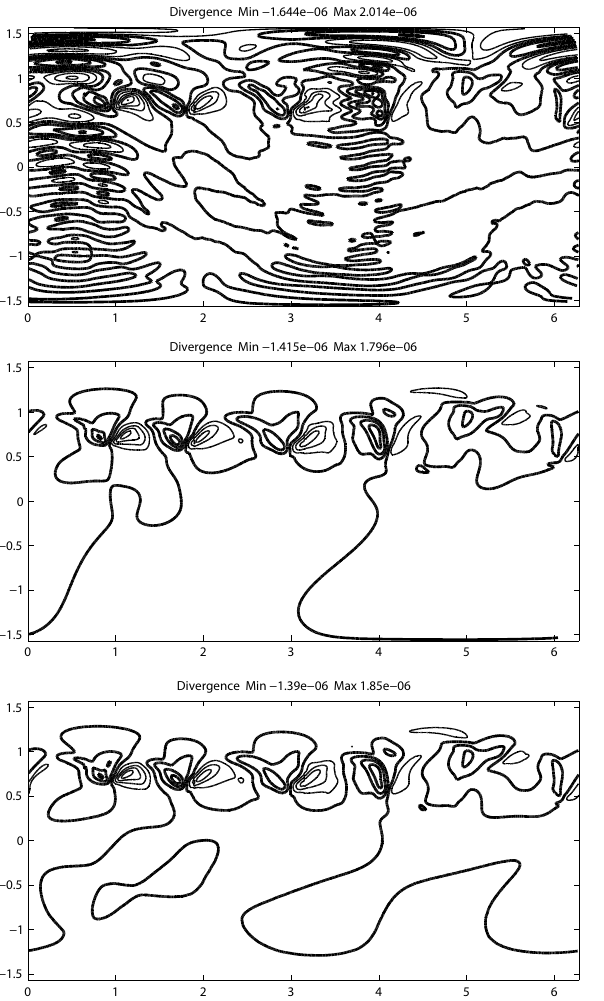
Figure 10. Divergence field at day 6 from three integrations of the mimetic finite volume model on a hexagonal grid of 163842 faces. Top: α = 0 . 5. Middle: α = 1 . 0. Bottom: α = 1 . 0 for 500 steps then α = 0 . 5. Contour interval 4 × 10 − 7 s − 1 , zero and negative contours are bold.